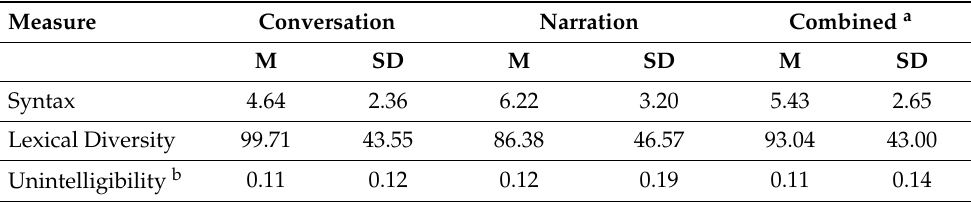
Table 2. Means and Standard Deviations for the ELS Measures.